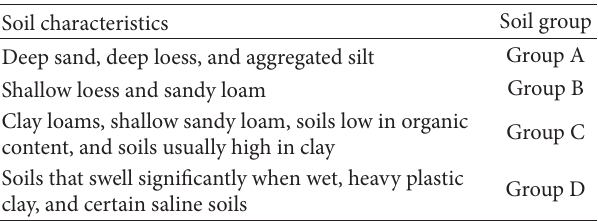
Table 1: Different soil group classifications